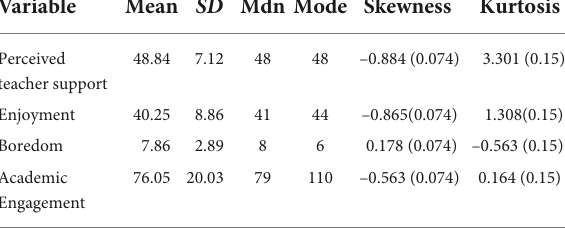
TABLE 2 Descriptive statistics for the four variables ( N =